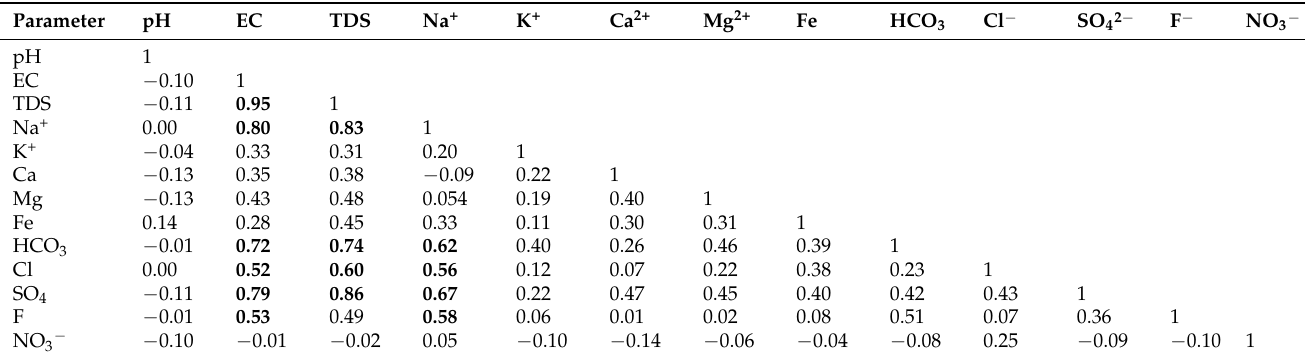
Table 2. Pearson correlation matrix of the study area’s physiochemical parameters for groundwater.